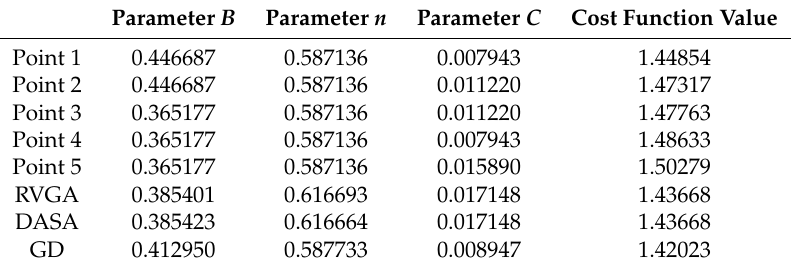
Table 6. Taguchi response surface.